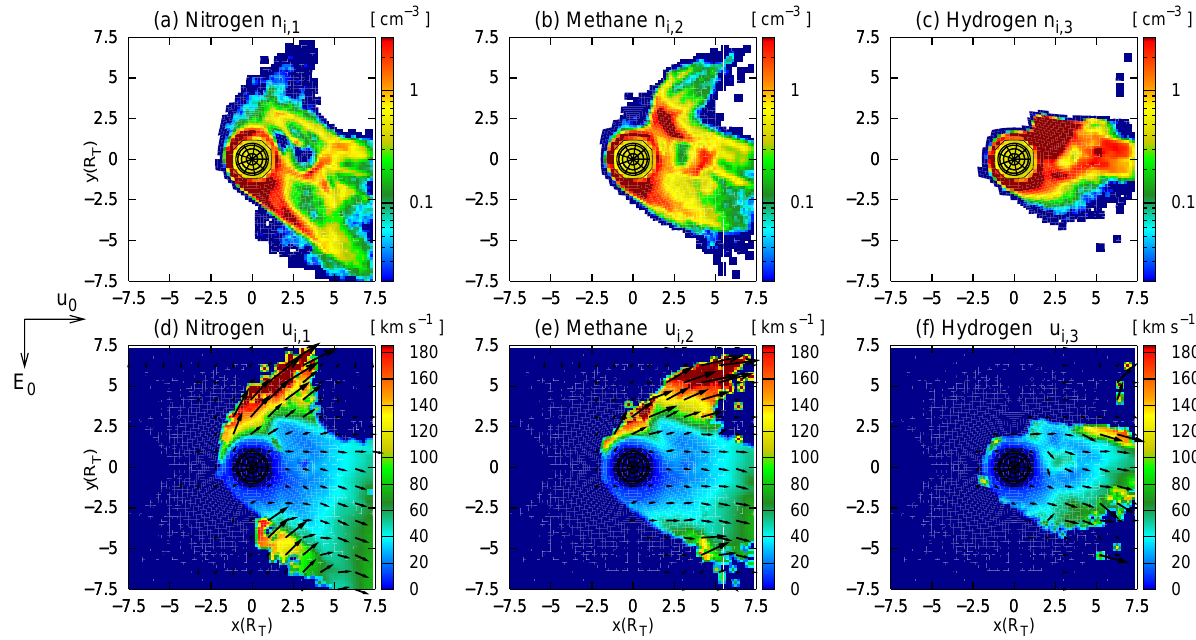
Fig. 8. Run #3 : Titan’s plasma environment under the influence of a periodic distortion according to eqs. (8) and (9). The period T = 2 π/ω of the distortion is T = 3500 δt , where 1333 δt correspond to the duration in which the magnetospheric plasma would pass through the simulation box one time. The plot shows the ionospheric plasma densities n and velocities u that correspond to the foregoing figure.